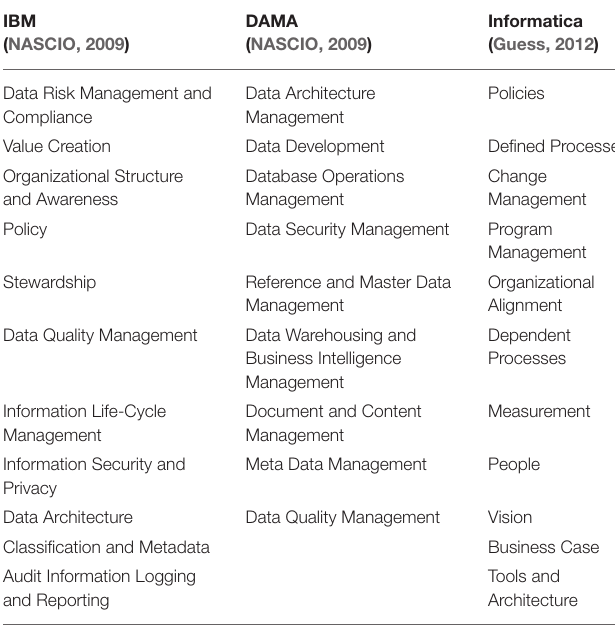
TABLE 1 | A sample of data governance frameworks and their major